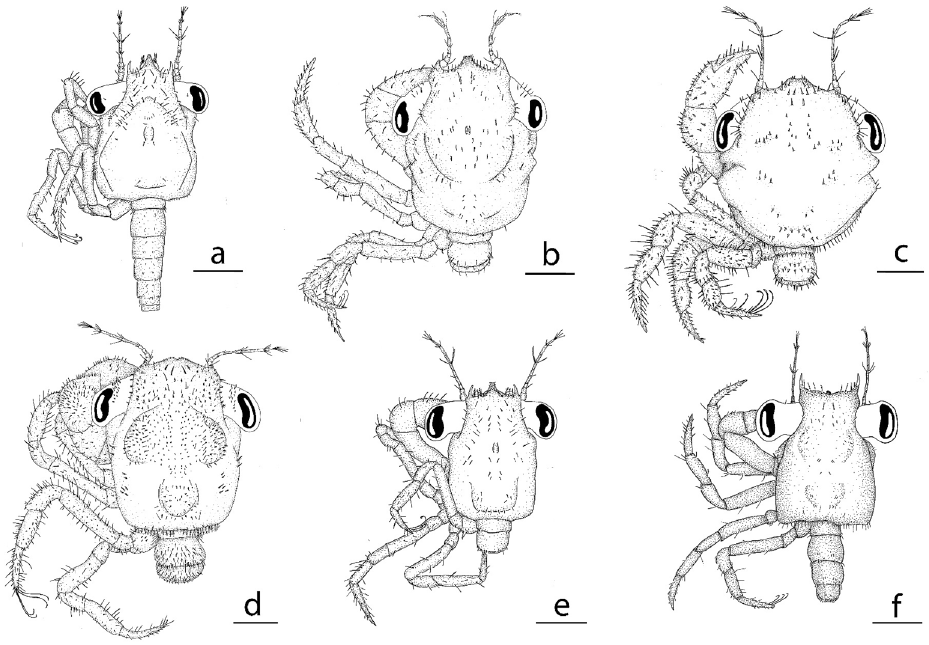
16, 10, 7–8, 7, 7 setae respectively; exopod 2-segmented with 3 distal simple setae on proximal segment and 5 terminal plumose setae on distal segment. Pereiopods (Fig. 6i–k, j1) Cheliped sparsely setose as shown, with prominent ischial curved hook; pereiopods II–V thin and setose, inner margin of dactyl with 3 stout spines and 2 shorter lateral spines; pereiopod II with a tubercle on ischial segment; dactylus of pereiopod V with 3 long setae (feelers). Sternum (Fig. 8j) Maxilliped sternites completely fused with 4 simple setae, cheliped sternites with 2 simple setae each, pereiopod sternites 2–5 without setae; sternal sutures are interrupted medially. Pleon (Fig. 5a) Six pleonites; setation of pleonites II-VI as shown; pleonite VI reduced. Pleopods (Fig. 6l, m) Present on pleonites II-VI; endopods unsegmented with 3 cincinuli; exopod unseg- mented with 16, 14, 14, 14 long plumose natatory setae; uropod 2-segmented, proximal segment with 1 seta, distal segment with 9 terminal plumose natatory setae. Telson (Fig. 5a) Reduced, with 1 pair of dorsal setae. Distinctive morphological features for Liomera cinctimanus , Pseudoliomera variolosa , Williamstimpsonia stimpsoni , Scopolius nuttingi and Etisus odhneri are listed in the Table 3 and illustrated in the Figs. 5b–f, 7b–p, 8k–o.